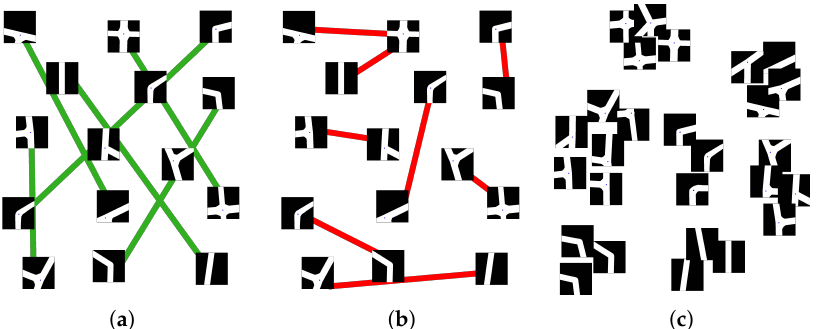
Figure 11. The picture depicts the position of MBEVs in the vector space together with their pairwise distances (colored edges), visually showing the intuition behind the metric learning approach. Same class (green) and inconsistent, different-class (red) edges in panels ( a , b ), respectively, are used to find a metric in a way that similar images are grouped together in clusters, as visible in ( c ). The images shown here are generated with the intersection model presented in Section 4.4. Besides this first intuition of constraints in terms of pairs , we can imagine triplets to further increase the complexity of the optimization problem, helping the system to obtain better and wider distances between clusters.